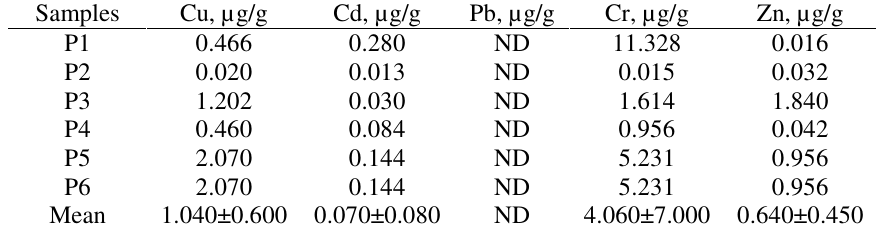
Table 2. Concentration of heavy metal in six different samples of